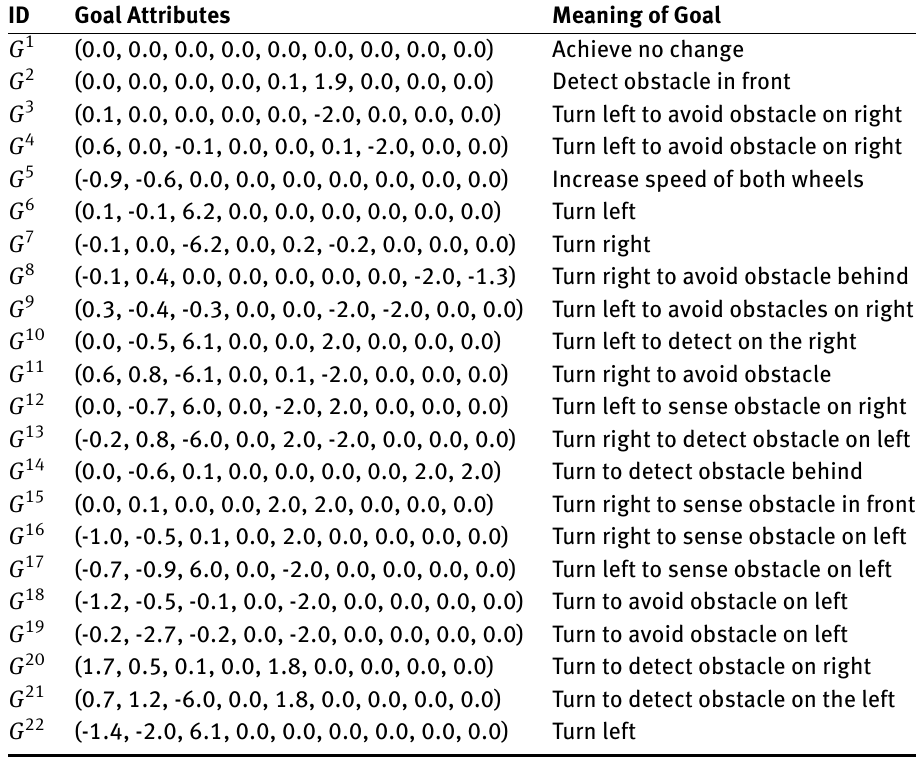
Table 3: Achievement goal prototypes generated in the first run of experiment 1 with ρ M = 0.9. Weights are rounded to 1 decimal place.